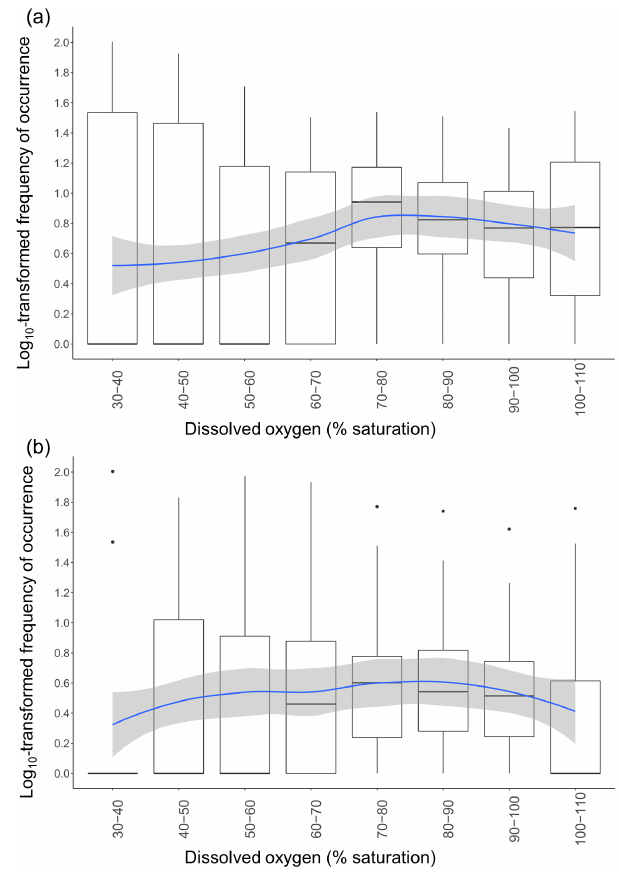
Figure 5. Variation in frequencies of occurrence of fish across DO class. Frequencies of occurrence were log 10 -transformed. Each data point used to draw the boxplots represents the frequency of occur- rence of one common taxon during a specific DO class. The blue line represents the GAMM model fitted with DO as the smooth term using a Gaussian distribution and an identity link function for (a) edge sites and (b) in-forest sites. Shaded areas represent the confidence interval at 95%.